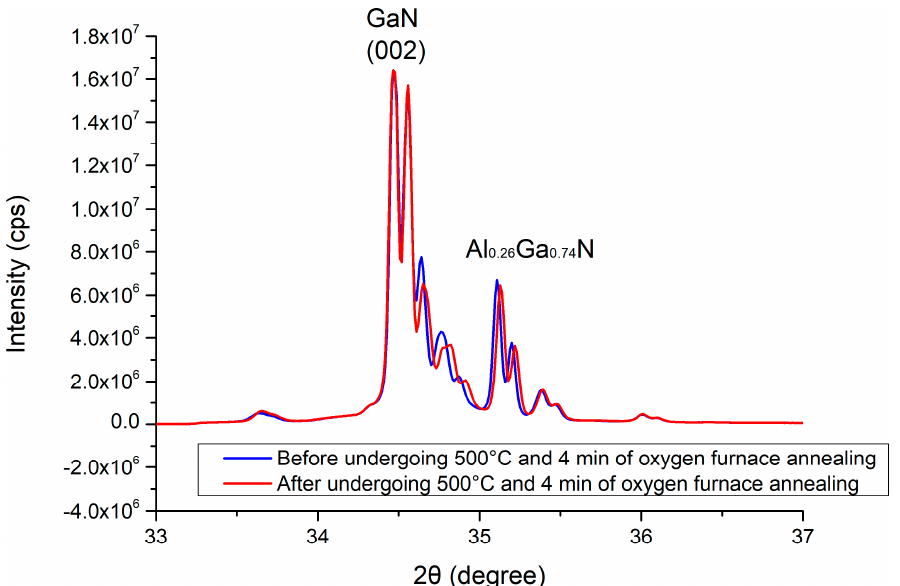
Figure 9. XRD measurements of the Ga 2 O 3 thin film deposited on the GaN wafer before (blue curve) and after (red curve) undergoing 500 °C annealing for 4 min.